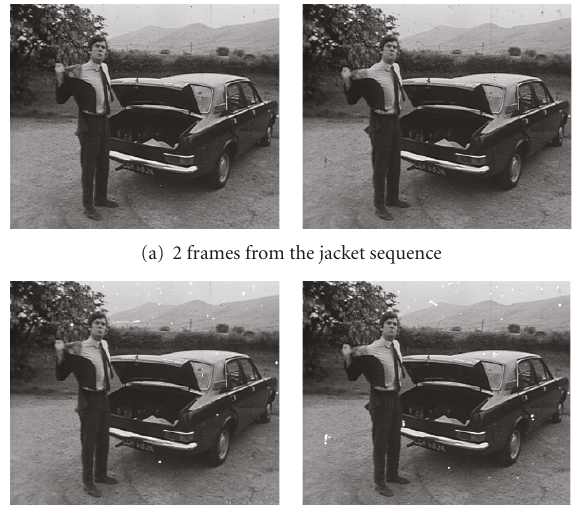
Figure 7: The second ground truth sequence is the “jacket” sequence. As the person in the sequence removes his jacket, the motion of the jacket is pathological and is an example of nonrigid object motion. This sequence has a higher blotch frequency than the “dance”